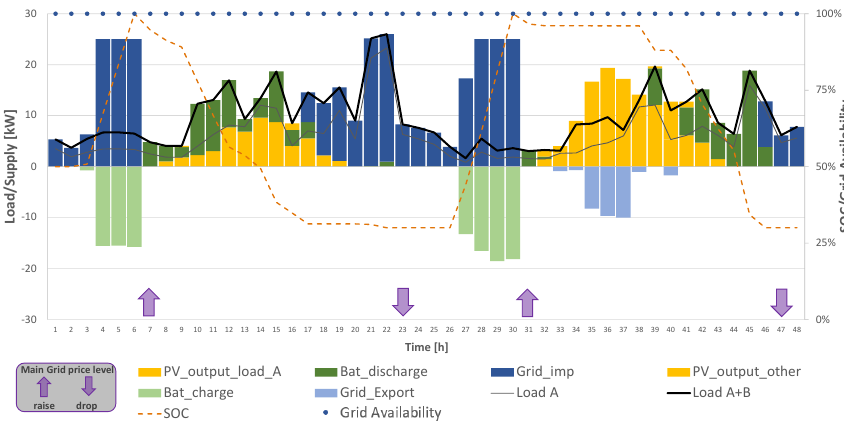
Figure 9. UMG optimal dispatch for rainy season and full